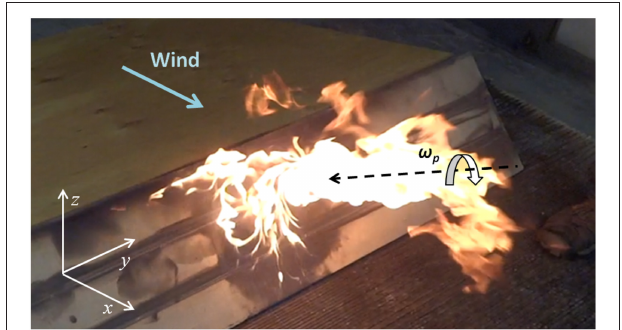
FIGURE 1 | Experimental fire in a wind tunnel showing a fire whirl (vortex) on the leeward slope of an idealized ridge. Note that the vortex is on the left flank of the fire and has components ω x , ω z < 0. The pyrogenic vorticity ω p and its orientation are indicated in the figure. The figure has been adapted from Sharples et al.